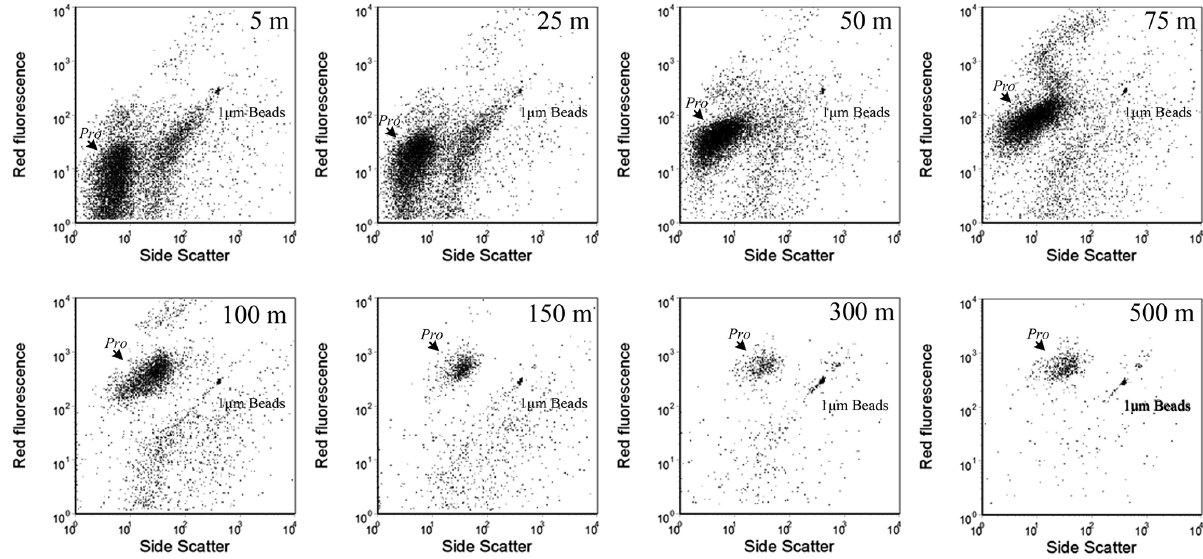
Fig. 1. Flow cytograms of Prochlorococcus samples at different water depths from the Luzon Strait (St. LX02) demonstrating the status of the Prochlorococcus populations along the water depth.